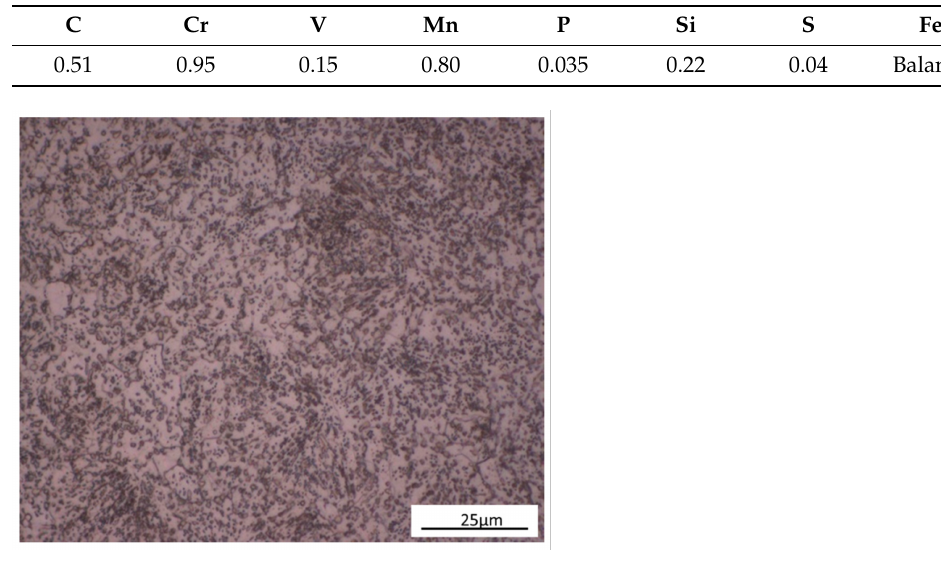
Table 1. Chemical composition of AISI6150 steel (wt. %).